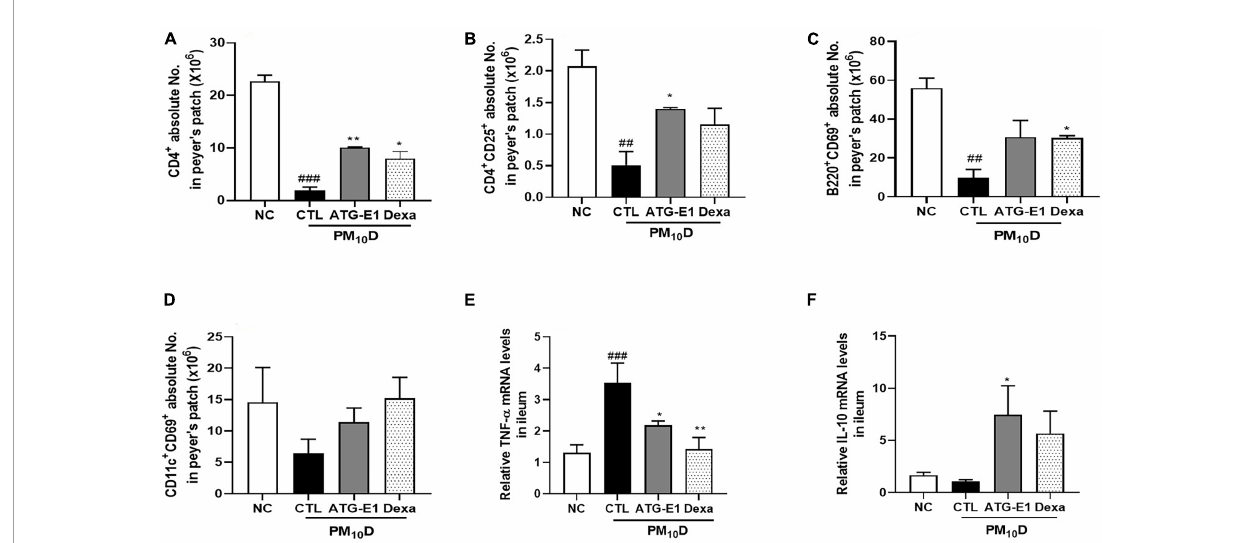
FIGURE5 Effects of L. paracasei ATG-E1 on immune cell numbers and cytokine expression levels in the peyer’s patch and the ileum of a PM 10 D-induced airway inflammation animal. (A) CD4 + , (B) CD4 + CD69 + , (C) B220 + CD69 + , and (D) CD11c + CD69 + absolute cell numbers in peyer’s patch. (E) TNF- α , and (F) IL-10 mRNA expression levels in the ileum. The data are presented as means ± SEM ( n = 8). ## p < 0.01 and ### p < 0.05 vs. NC; * p < 0.05 and ** p < 0.01 vs. CTL. NC: normal mice; CTL: PM 10 D-sensitized control mice; Dexa: 3 mg/kg dexamethasone-treated PM 10 D-sensitized mice; ATG-E1: 4 × 10 9 CFU/day of L. paracasei ATG-E1-treated PM 10 D-sensitized mice.